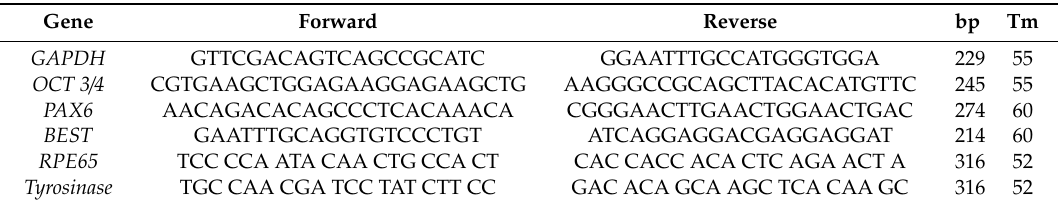
Table 1. Reverse-transcriptase–PCR primer sequences, product lengths (bp) and used